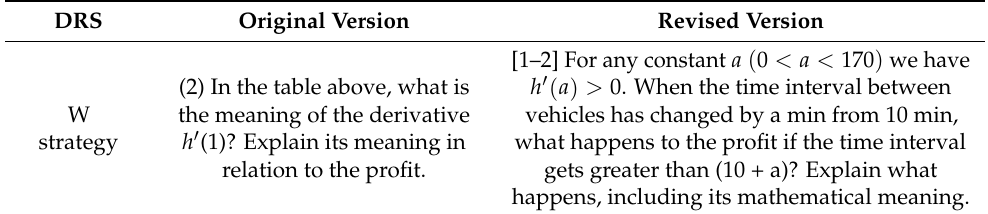
Table 5. W Strategy (Using Words Appropriate for